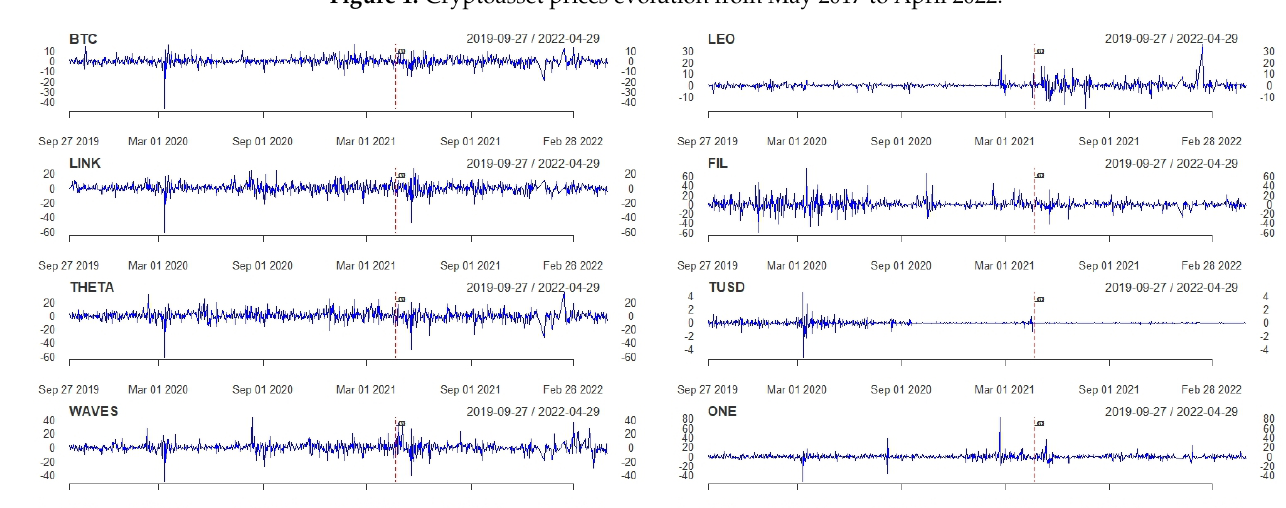
Figure 2. Cryptoasset returns in the sample spanning from May 2017 to April